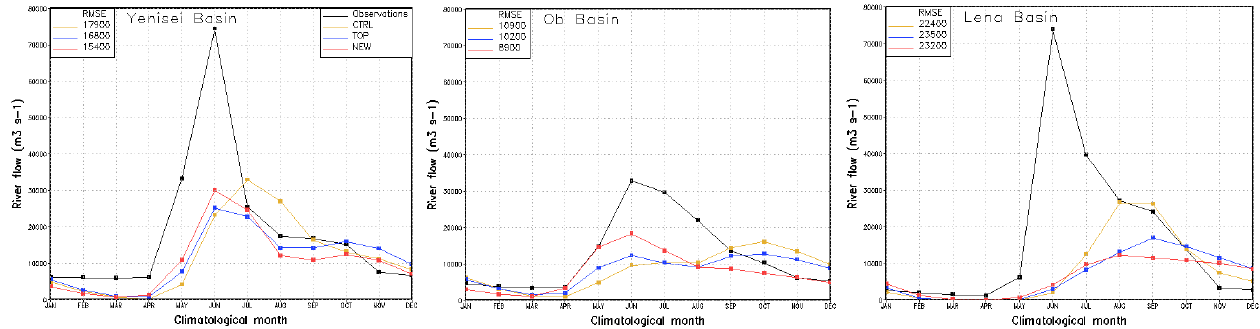
Fig. 5. Observed river flow of the Yenisei, Ob and Lena compared to model runs for each using CTRL, TOP and NEW. The points represent the average flow rate for a given month. Each observational point is a climatological average value of 60 consecutive years in the range 1930–1999, depending on the basin. The model points are a climatological average value for the decade 1989–1999. The RMSE values are the yearly-average values.